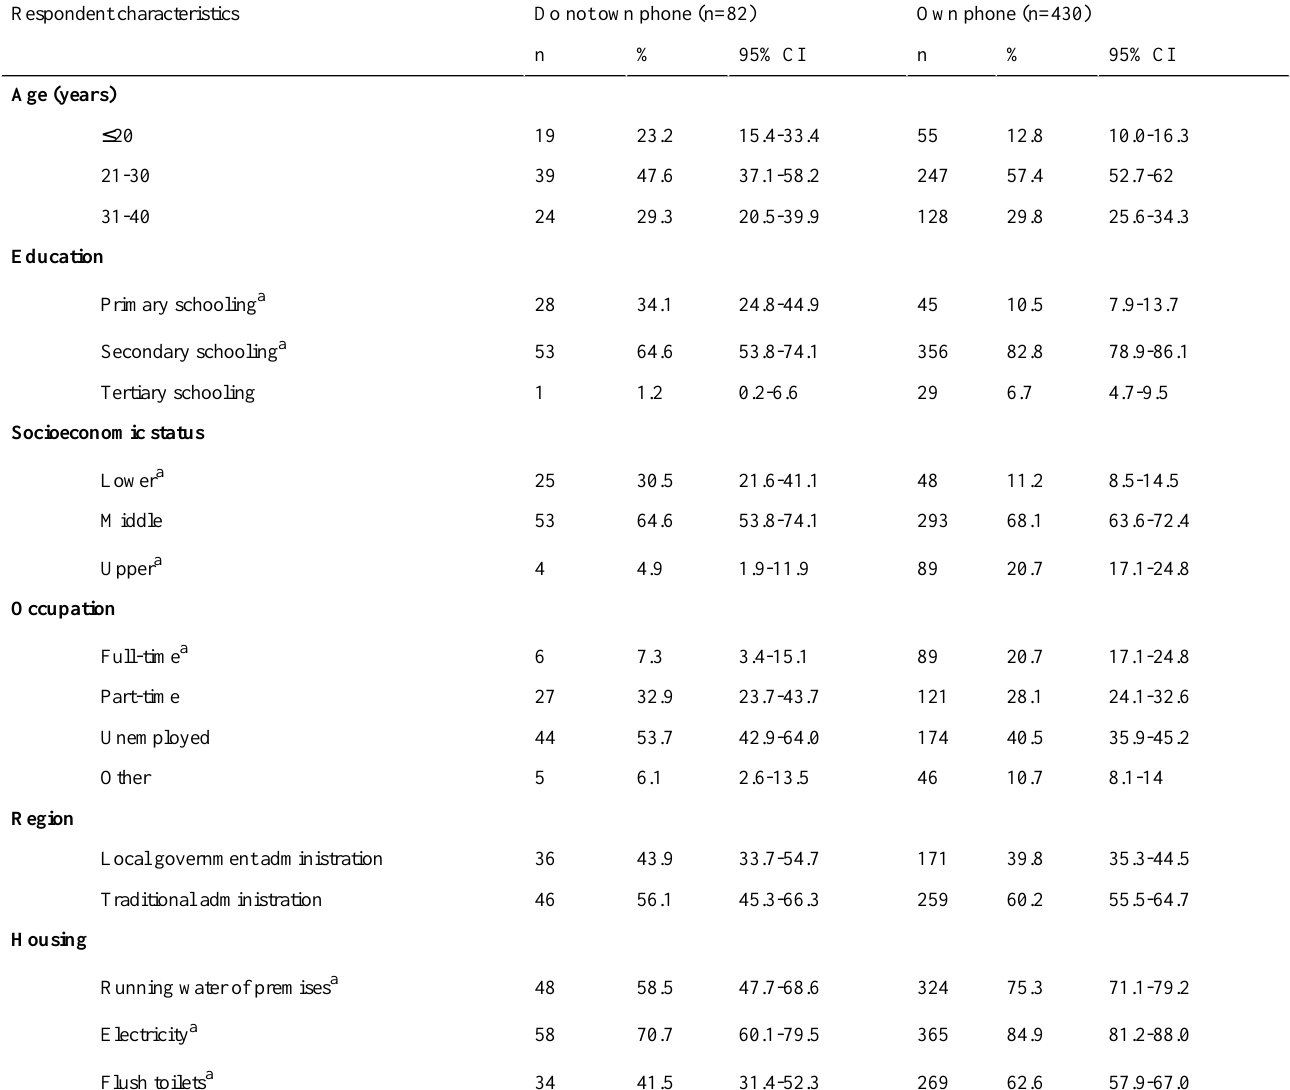
Table 3. Demographic characteristics of sample